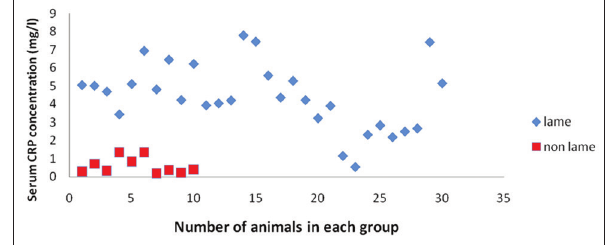
Figure-2: Scatter diagram showing haptoglobin concentration in lame and non-lame healthy crossbred cows.